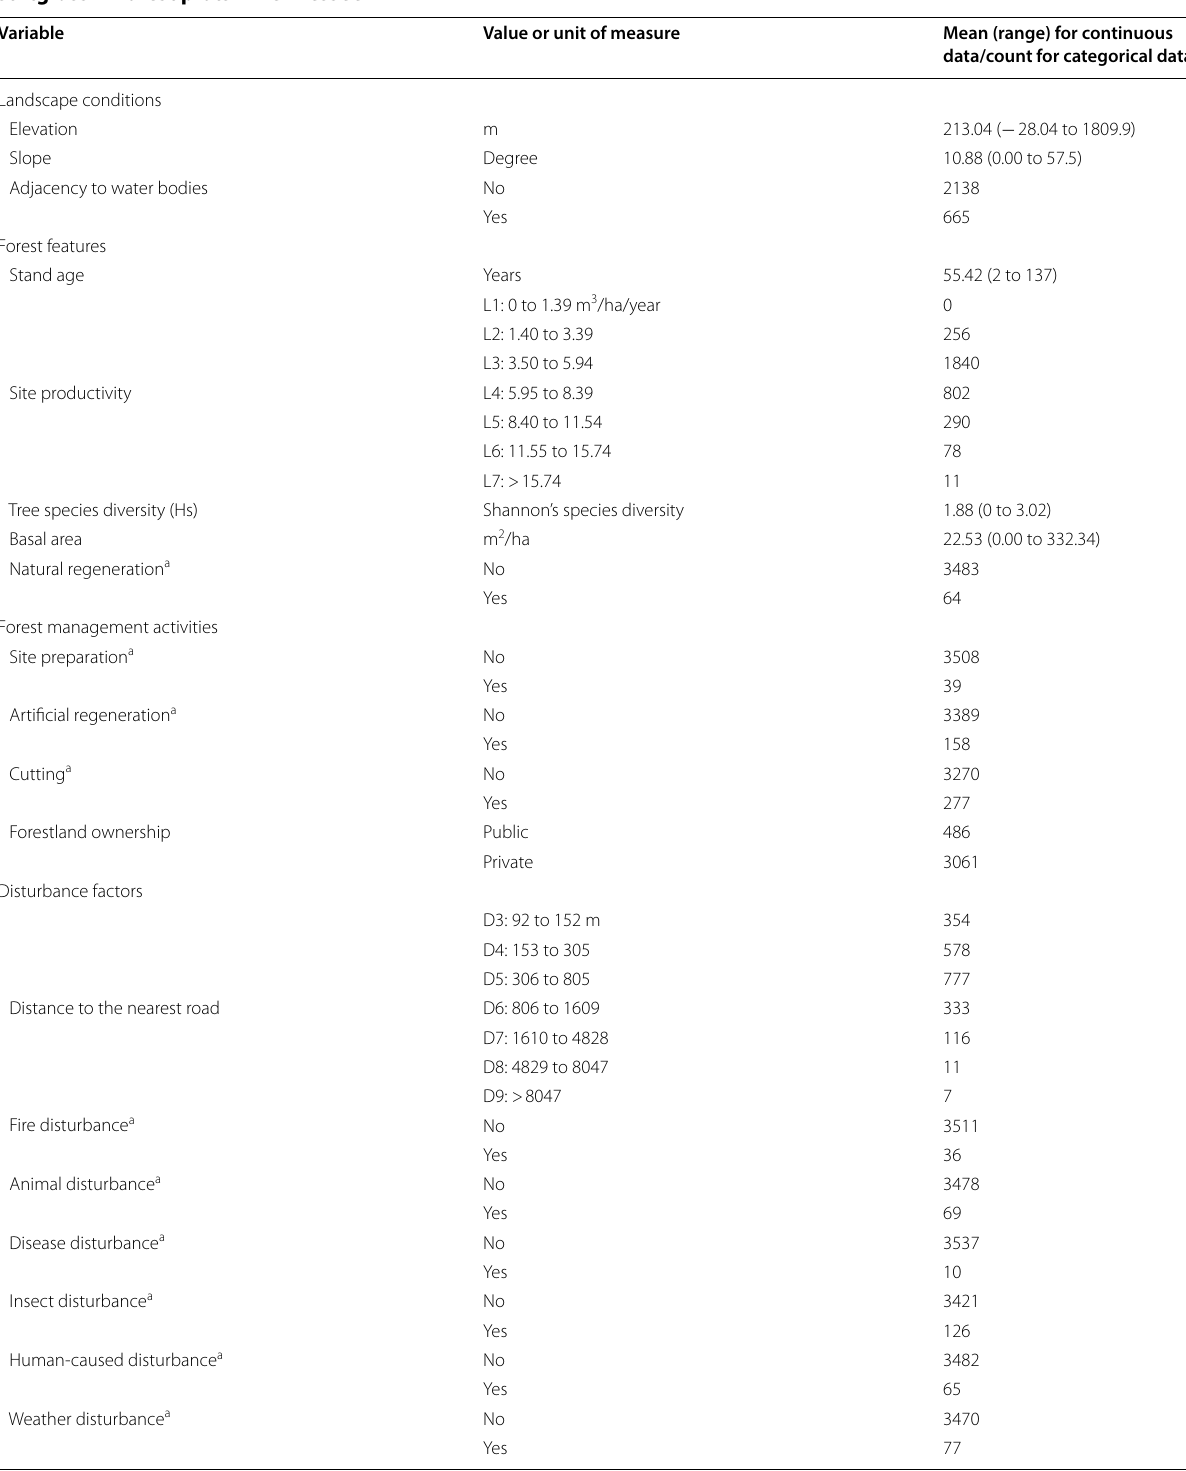
Table 1 Descriptions, possible values or units of measure, and means or counts of landscape conditions, forest features, forest management activities, and disturbance factors evaluated as potential factors of site invasion by Japanese stiltgrass in forest plots in Tennessee Value or unit of measure Mean (range) for continuous data/count for categorical